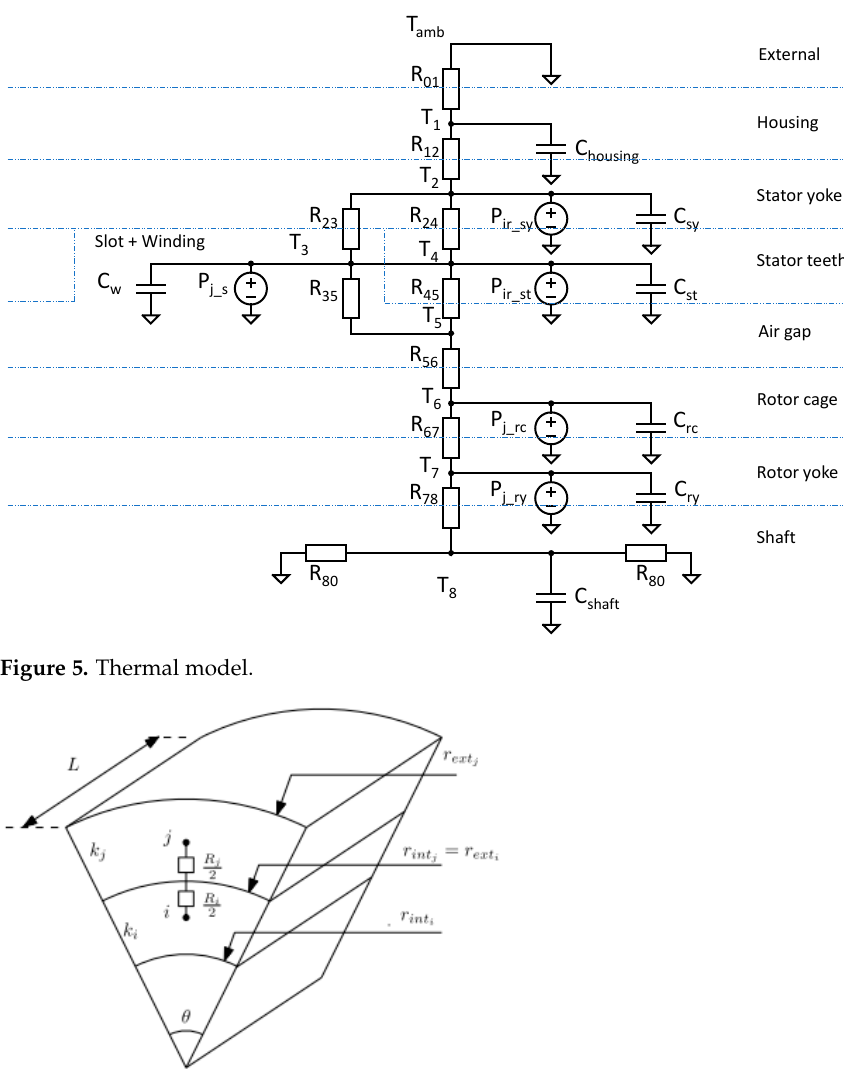
Figure 6. Thermal resistance of radial convection.